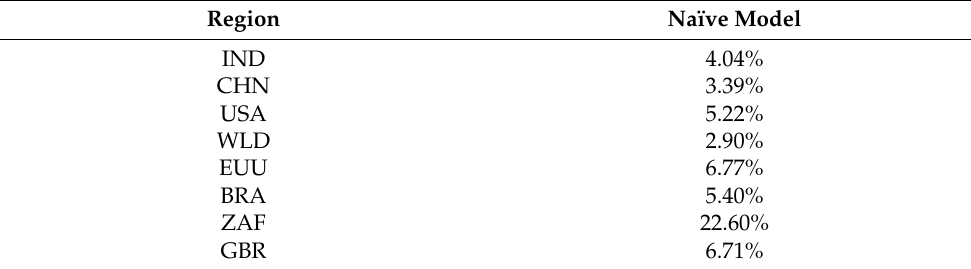
Table 14. The mean average percentage error (MAPE) on the test set, per region, using the naïve model. Region